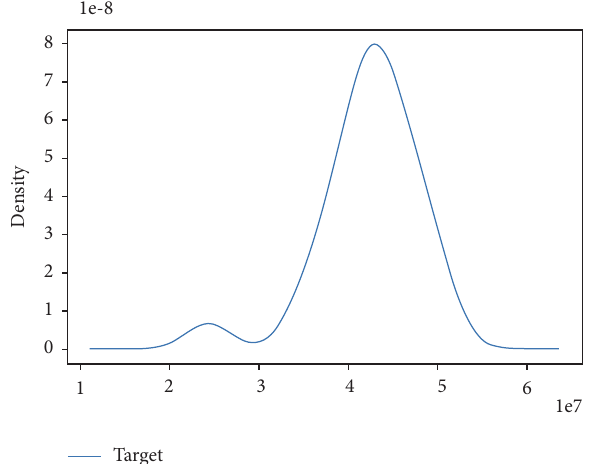
Figure 5: Trend diagram of the normal test.